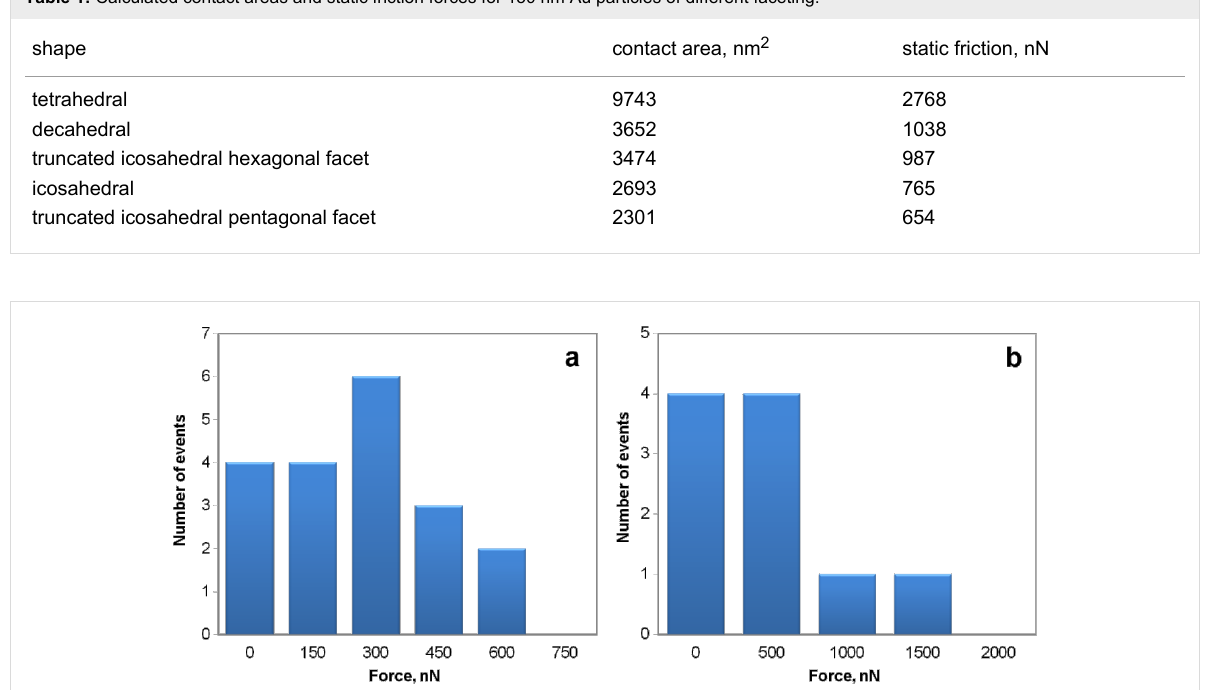
Table 1: Calculated contact areas and static friction forces for 150 nm Au particles of different faceting.